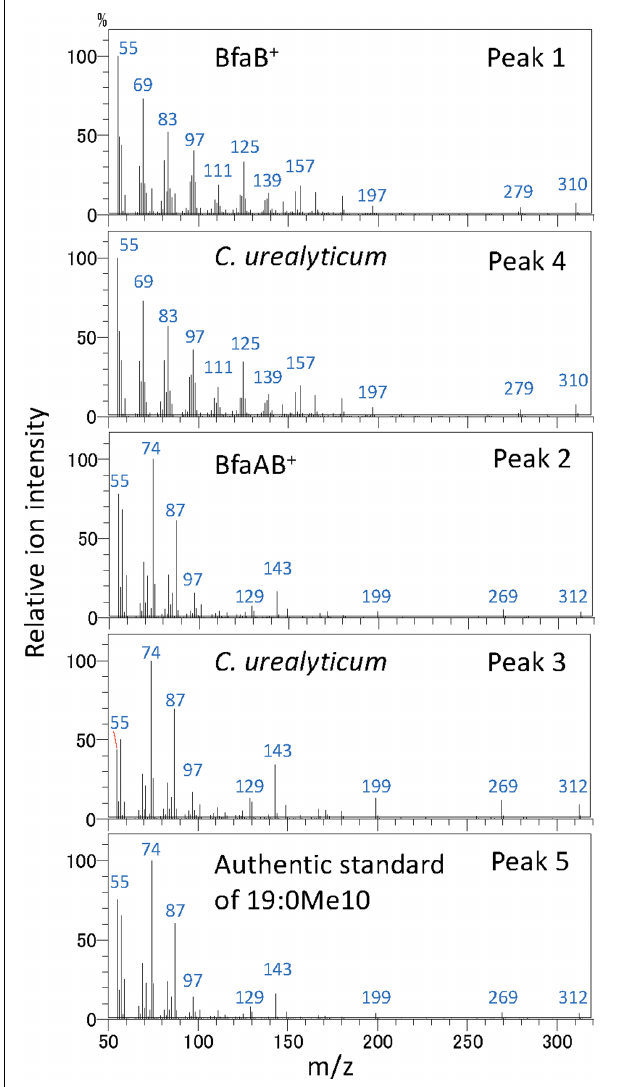
FIGURE 5 | Analysis of fatty acid methylesters by GC with a mass spectrometer. Mass spectra of fatty acid methylester were analyzed by GC with a mass spectrometer. Peak 1, fatty acid extracted from bfaB + strain; peak 2, fatty acid extracted from bfaAB + strain; peaks 3 and 4, fatty acids extracted from C. urealyticum cells; and peak 5, authentic standard of 10-methyl stearic acid. The numbers in this Fig are linked with the peaks in Figure 4 . BfaA and BfaB indicate FAD-binding oxidoreductase and WP_048472121, respectively.